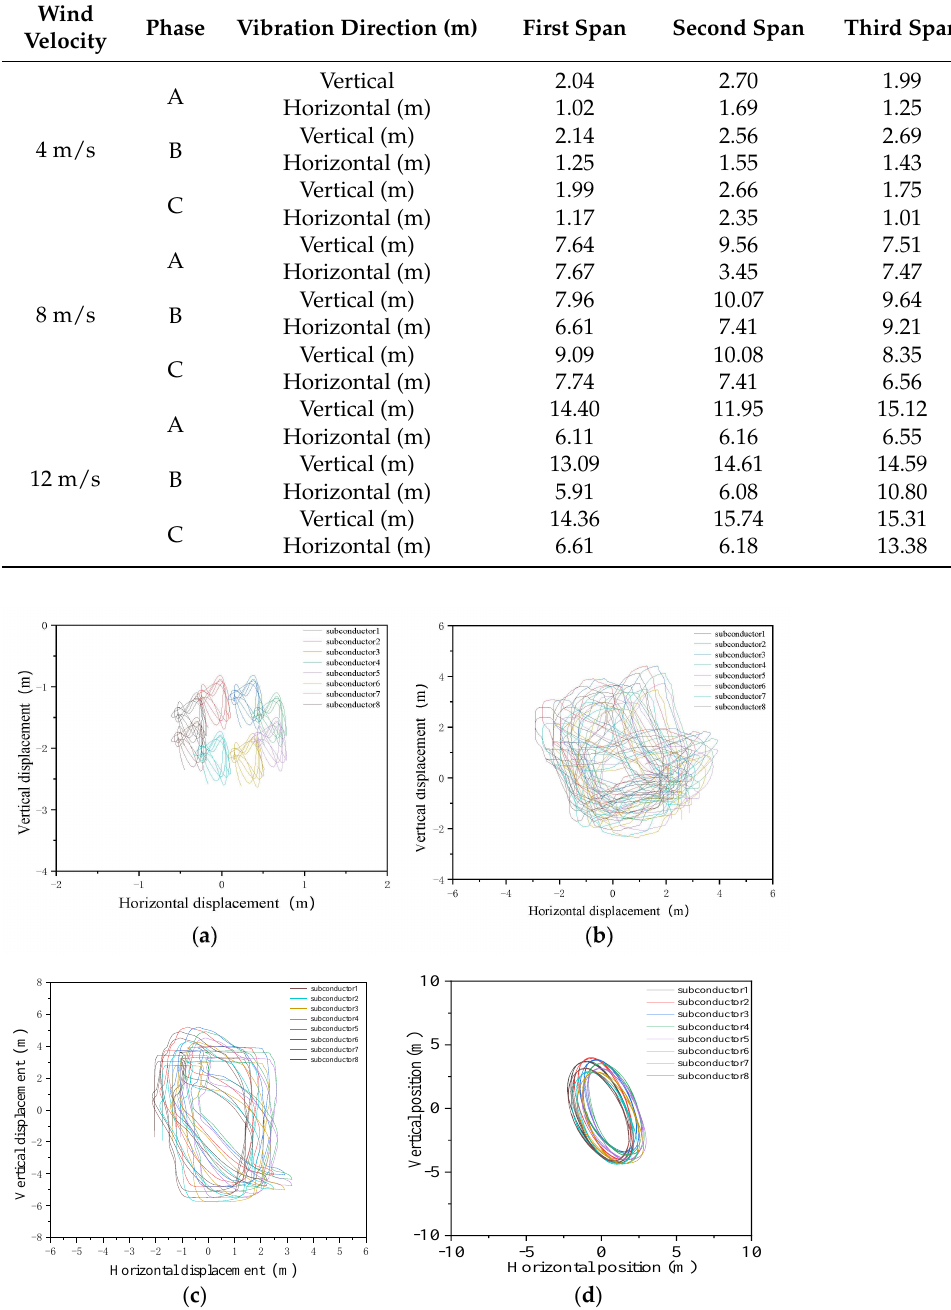
Figure 9. Trace diagram of Conductor displacement: ( a ) Trace diagram of the midpoint displacement at wind velocity 4 m/s; ( b ) Trace diagram of the midpoint displacement at wind velocity 8 m/s; ( c ) Trace diagram of the midpoint displacement at wind velocity 12 m/s; ( d ) Ding’s trace diagram of the midpoint displacement at wind velocity 8 m/s.